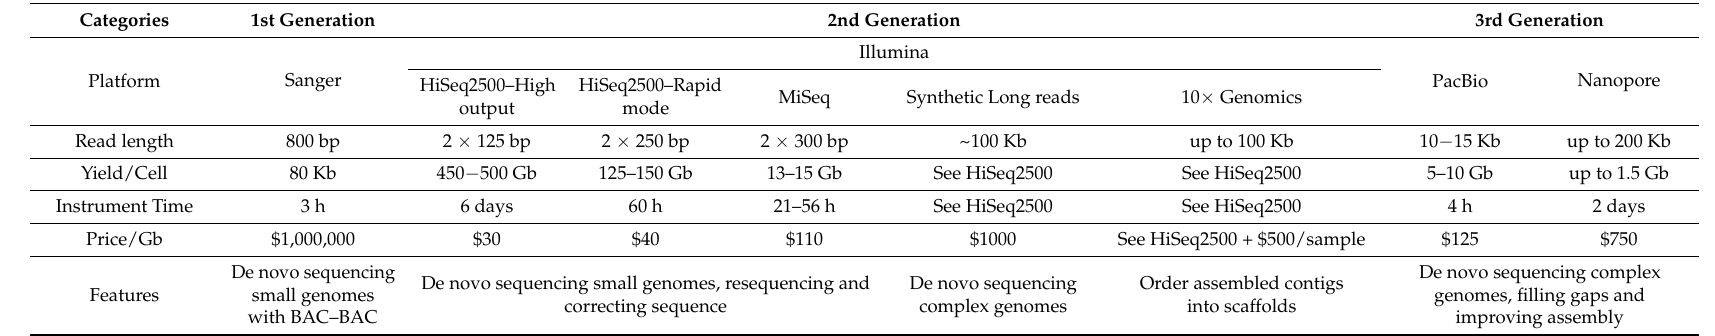
Table 1. Comparisons and summary of sequencing